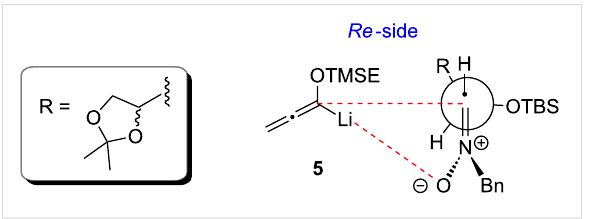
Figure 1: Proposed transition structure for the addition of lithiated TMSE-allene 5 to chiral nitrones 3 , 6 and 8